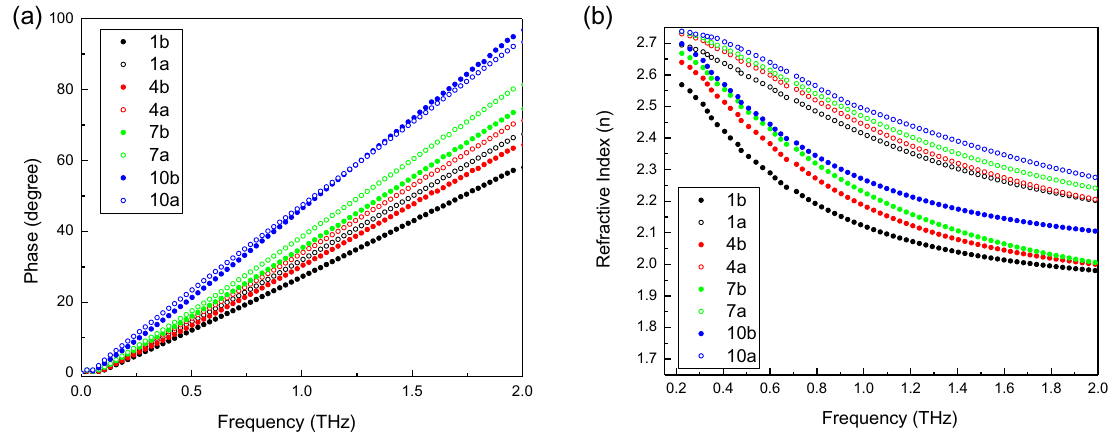
Figure 3. ( a ) Phase versus frequency; ( b ) Refractive index value versus frequency for cornea sample No. 1 at day 1, day 4, day 7 and day 10.